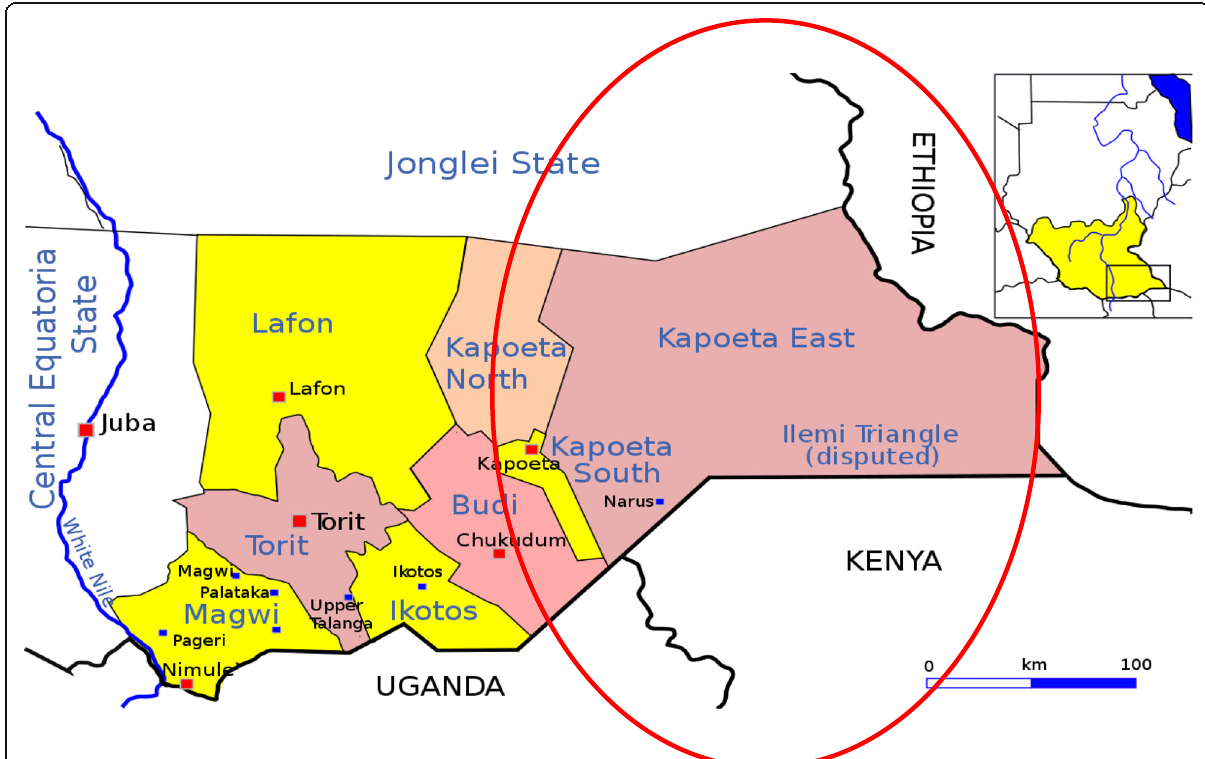
Figure 1 The circled area denotes the programme target area, bounded between the Jonglei State and Kenya. Main settlements are Narus and Kapoeta